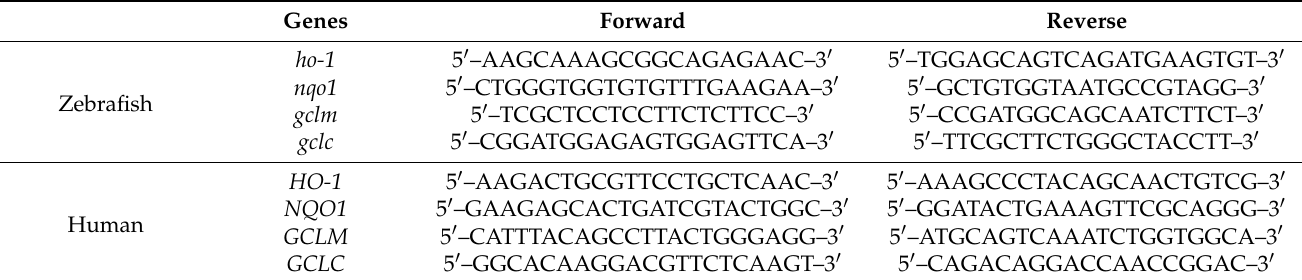
Table 3. The sequences of gene